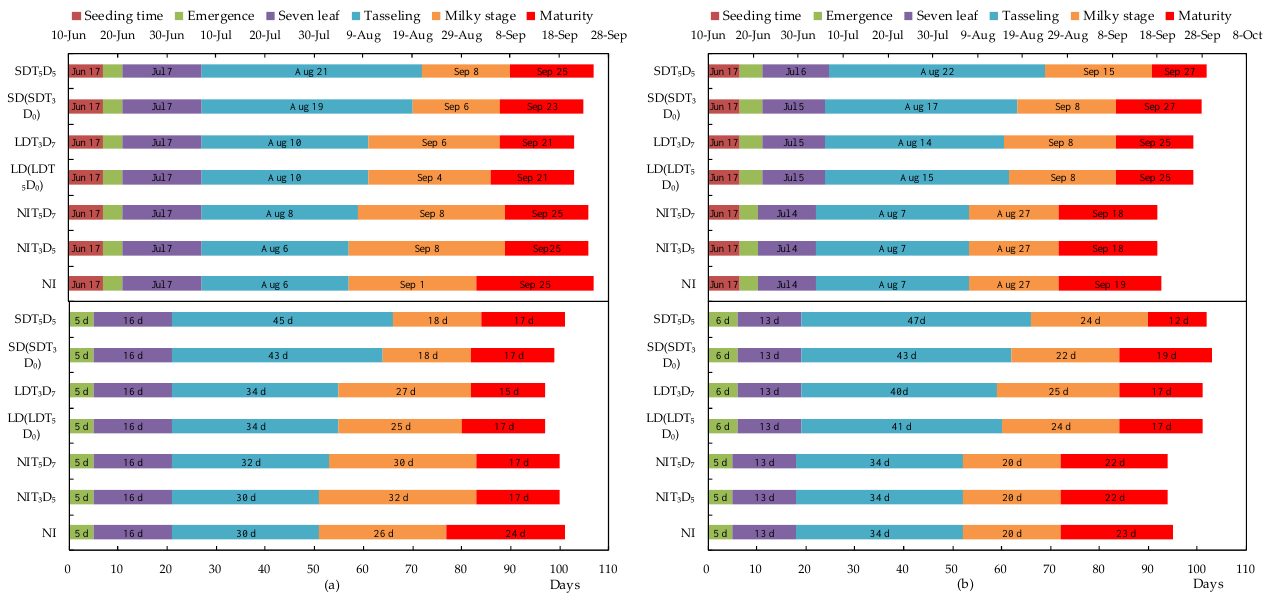
Figure 4. Maize phenology divided into sowing to beginning of seeding emergence, seven leaf stage, tasseling, milky stage, and end of maturity (upper half of each graph), and growing days (lower half part of each graph) for the growing seasons ( a ) 2016 and ( b ) 2017. The reproductive stages of maize were shortened by increasing temperature under sufficient water. Compared with NI, the mean advance of the reproductive stages was 1 day for NIT 3 D 5 , while it was 2 days for NIT 5 D 7 in 2016, and the mean advance of the re- productive stages was 1 day for LD and SD in 2017. The reproductive stages of maize were shortened under the synergistic effect of high temperature and drought. Compared with NI, the mean advance of the reproductive stages was 5 days for LDT 3 D 7 , while it was 11 days for SDT 5 D 5 . and advanced plant phenophase under the same soil moisture during the reproductive growth stage. The growth period of SDT 5 D 5 was the shortest, followed by LDT 3 D 7 , which were both under the synergistic effect of high temperature and drought; therefore, the synergistic effect of high temperature and drought promoted reproductive growth.